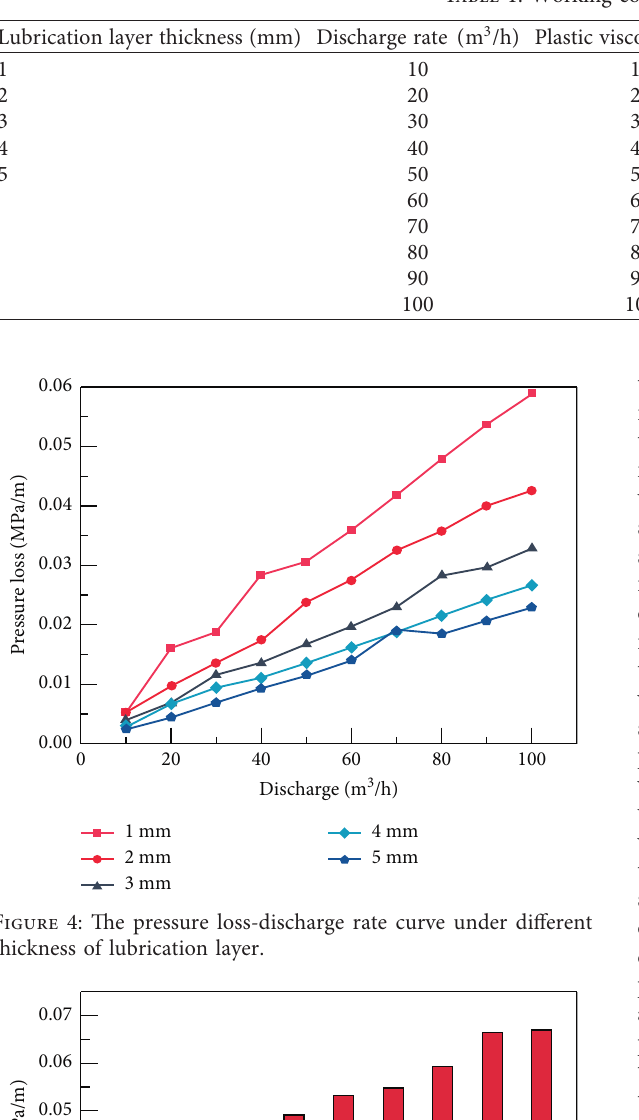
Table 1: Working conditions design.